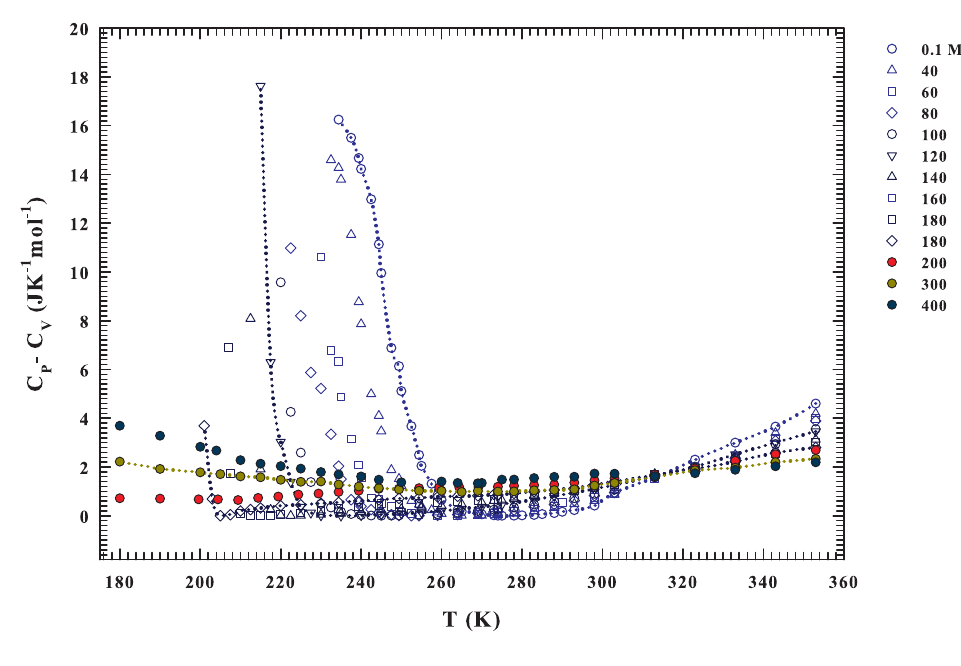
Figure 4. The calculated specific heat difference C P − C V for the different pressures ranging from 0.1 to 400 MPa, illustrated in the range 180 < T < 360 K . Also in the present case the pressure of 200 MPa is a crossover in the data behaviors; we have in fact C P (cid:29) C V only for P < 200